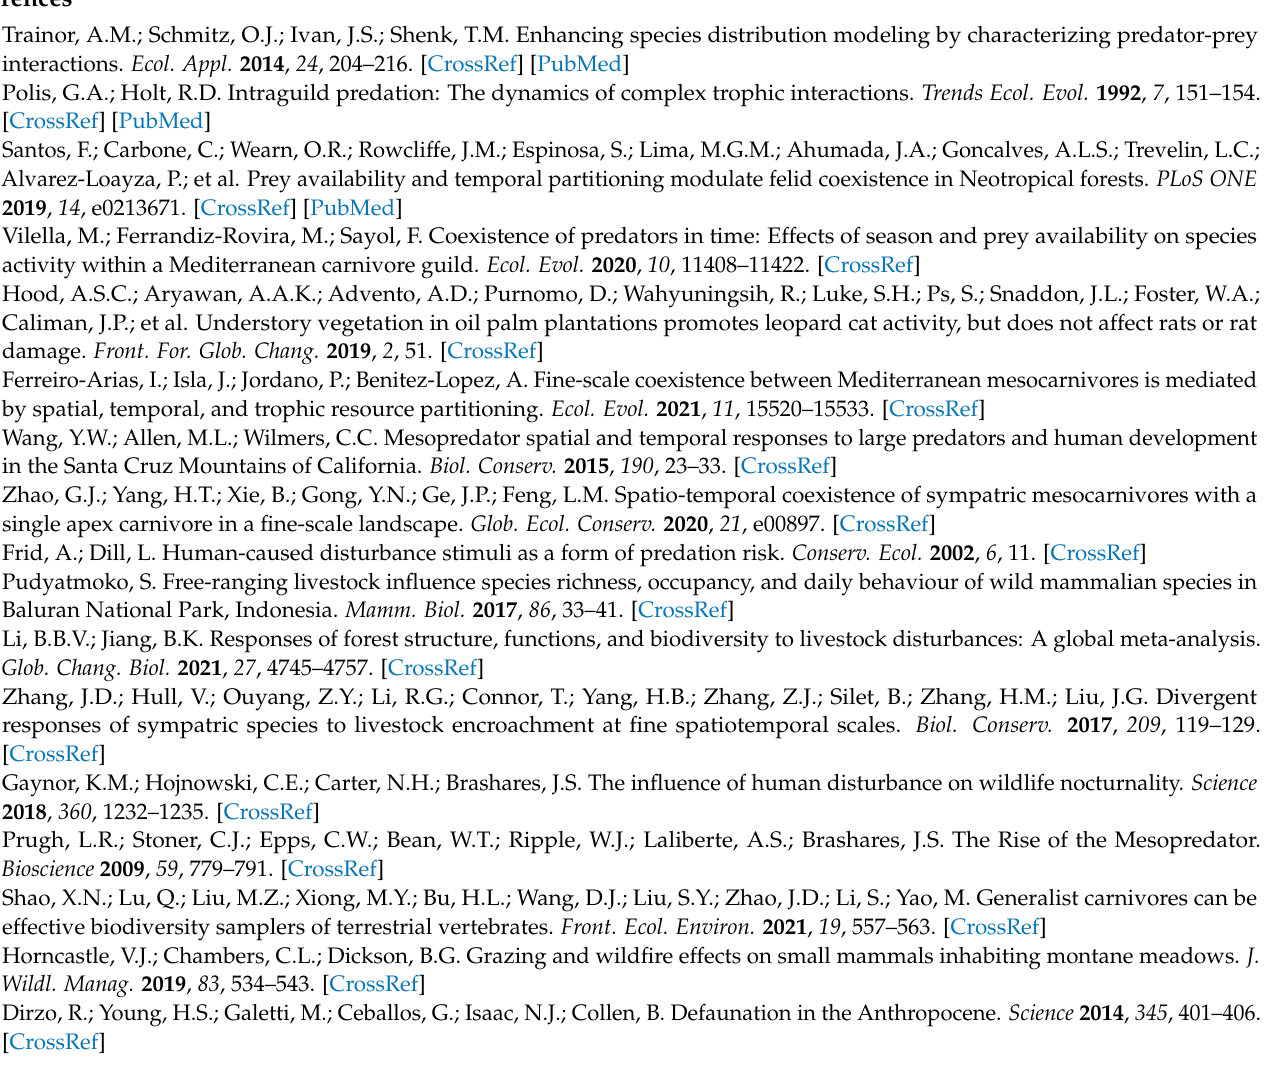
Table S7: Proportion of detections in each period of leopard cats and diurnal squirrels in higher and lower grazing